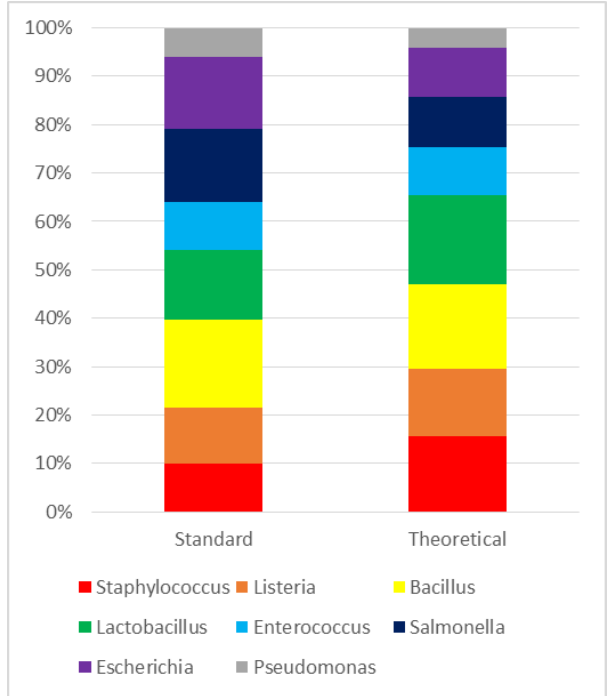
Figure 1. Bacterial composition of standard sample compared to its theoretical composition. Results are expressed as a percentage (%).